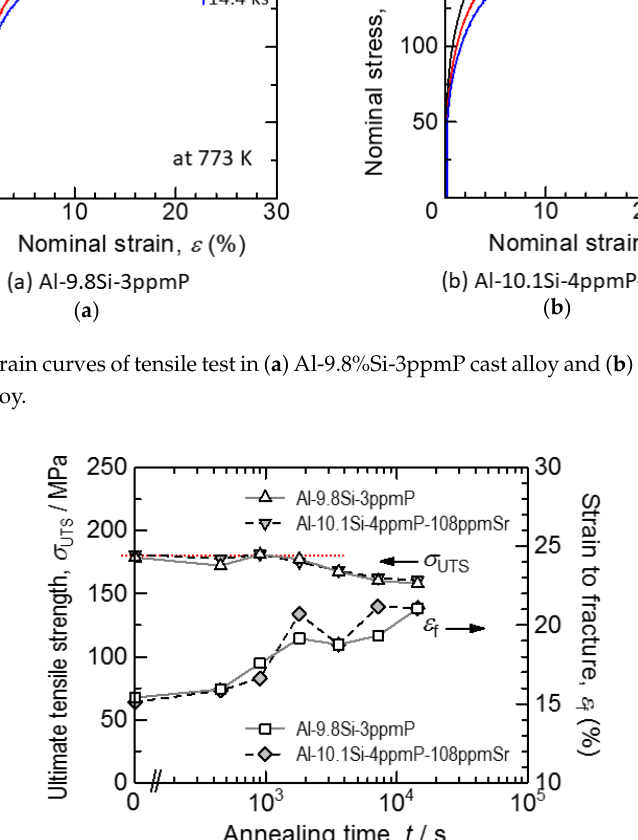
Figure 5. Changes in ultimate tensile strength and elongation during heat treatment at 773 K.